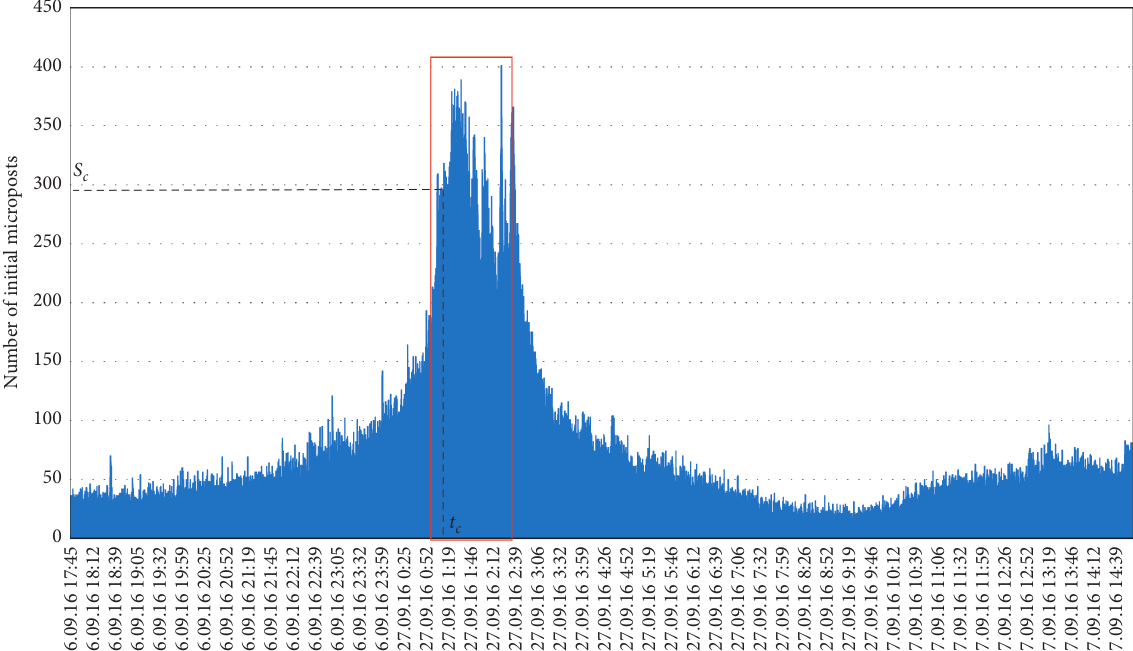
Figure 2: The dynamics of retweets corresponding to the first debate. t